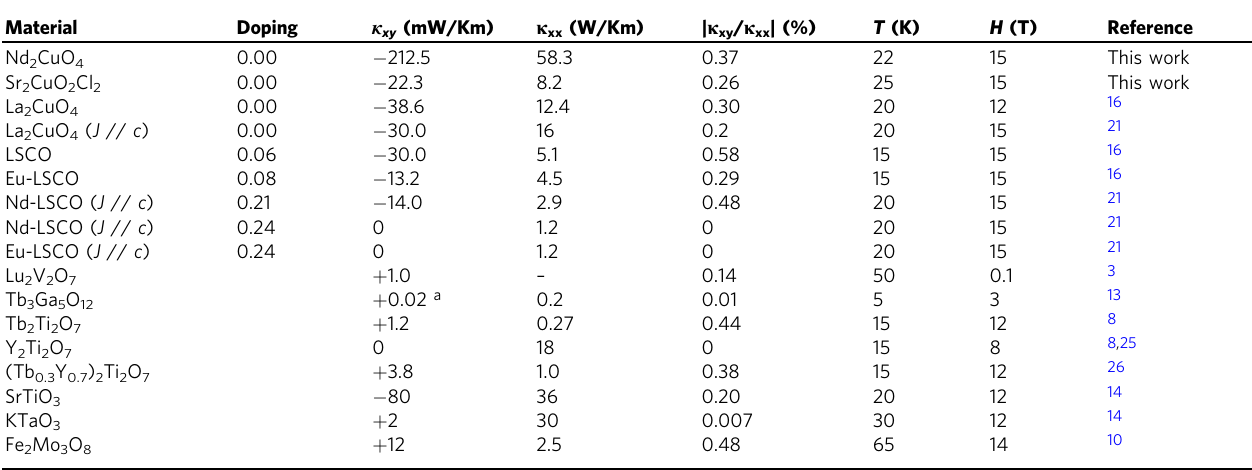
Table 1 Thermal Hall conductivity in various oxide insulators.